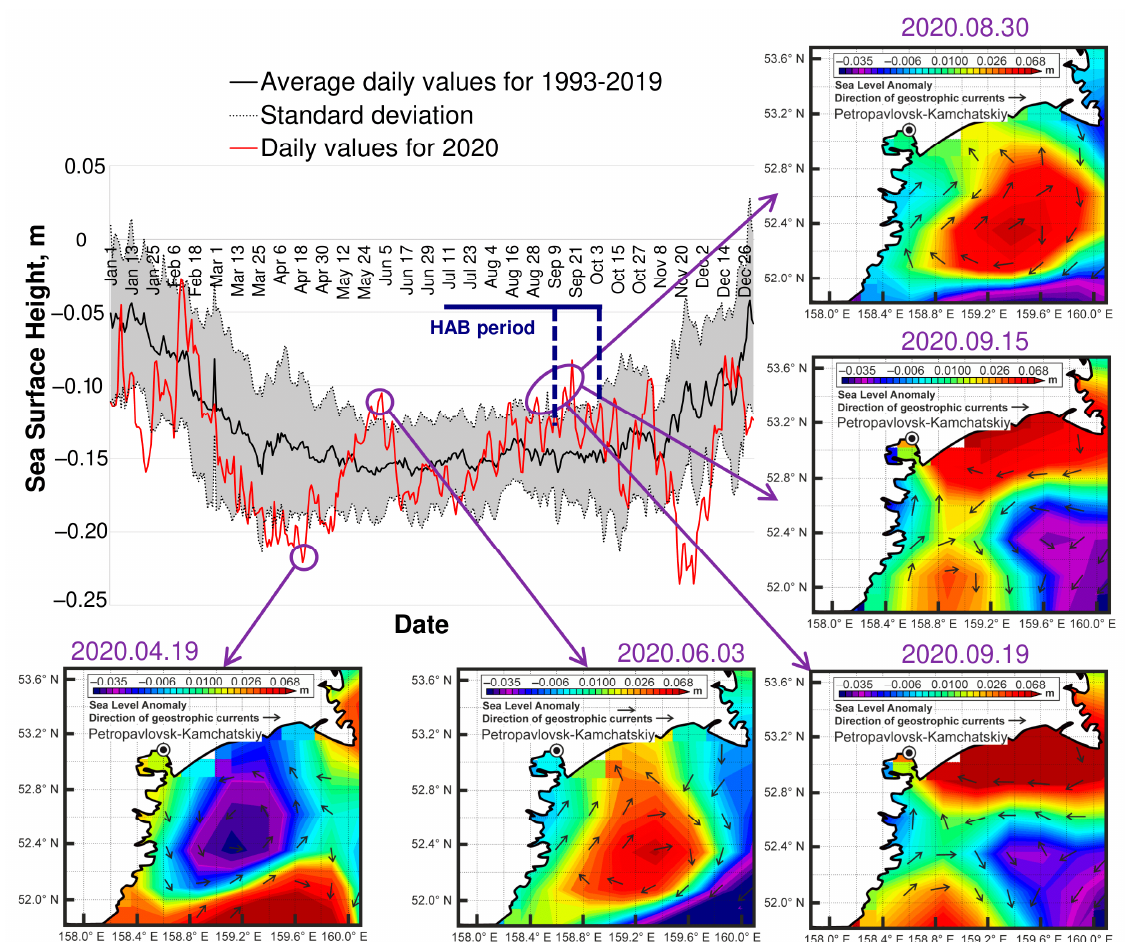
Figure 5. The graphs characterizing the annual variation of daily SSH (sea surface height) values for 2020 (red line) and summarized for the period from 1993 to 2019. SSH values (black line denotes average values, dashed lines denote standard deviations) characterizing the climatic norm (based on HYCOM data processing). The insets show spatial distributions of sea level anomalies and directions of geostrophic currents for the dates of registration of the anomalous sea level: 19 April, 3 Jun, 30 August, 15 September, 19 September (Aviso + data, 2020).